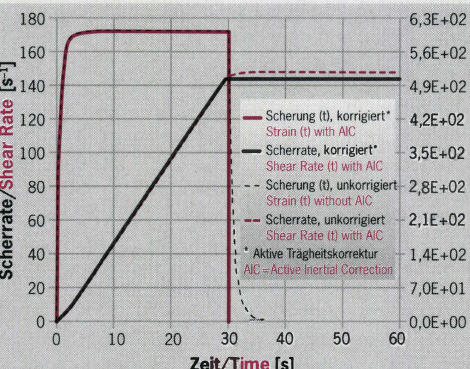
Abb. 6: Flie/Jkurve fur PVC-Plastisol (ermittelt im Mehrfach­ kriechversuch} Fig. 6: PVC Plastisol flow-curve from multistep creep test